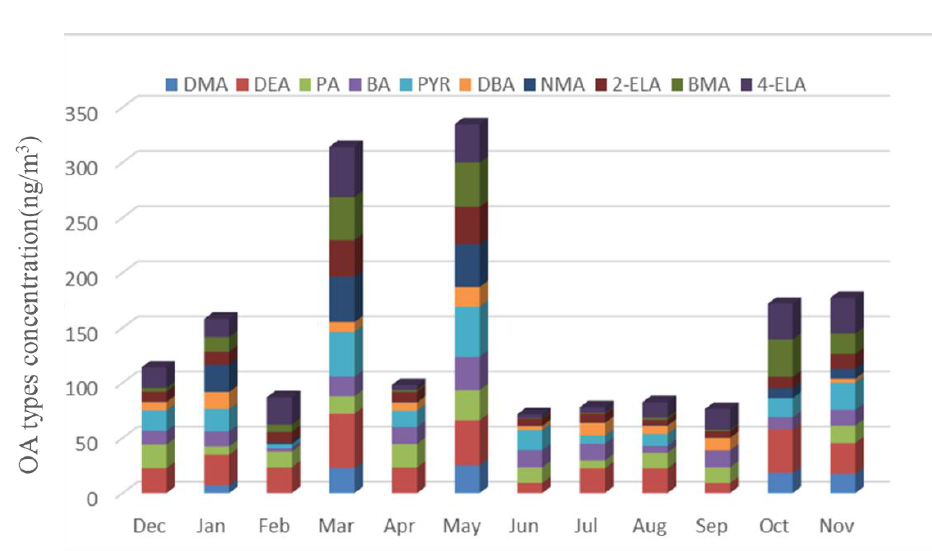
Figure 5. OA types and concentration (December 2020–November 2021).